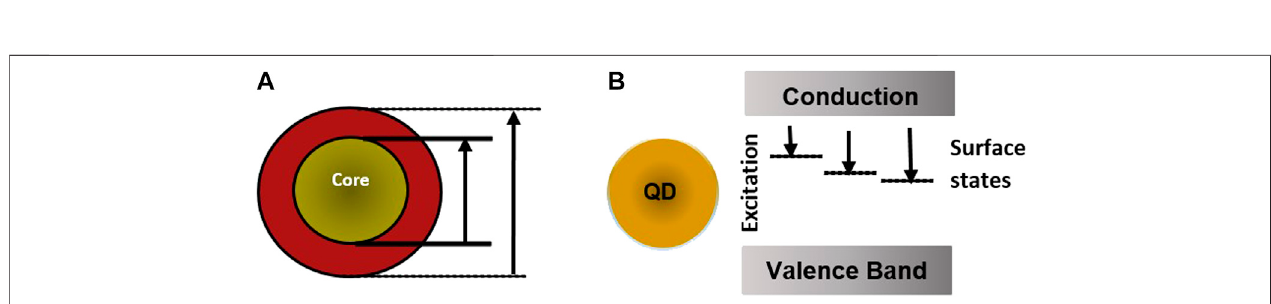
FIGURE 4 | Diagram illustration of the solid band structures of QD size variation effect on the transition energies. CdS QDs of different sizes, such as > 5.6, 5, and 2 nm,exhibit bandgap energies of2.42, 2.57, and 2.81 eV, respectively. A decrease in thesize ofCdSQDcaused an increase in bandgap energy anda splitinthe band energy distribution [48].